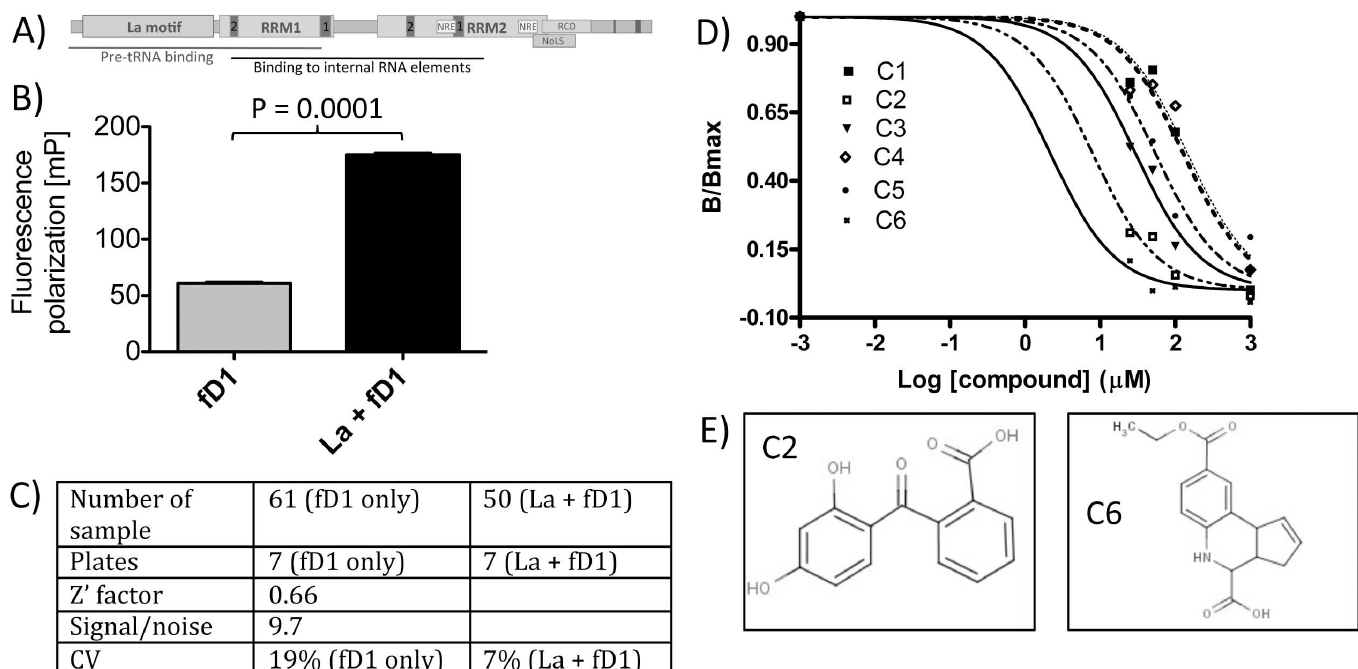
Fig 1. The La:RNA fluorescence polarization assay (La-FP assay). A) Domainstructure of La wildtype(La-WT). RRM = RNA recognition motif with RNP1 and RNP2 consensus sequences.Lines indicate which domainsare requiredfor bindingto different RNA substrates. NRE = nuclear retention element; NoLS = nucleolar localization signal;RCD = RNA chaperone domain; C-terminal dark bar = nuclear localization signal. B) Fluorescence polarization (FP) of the fluorescence-labeledcyclin D1-RNAoligonucleotide (fD1-RNA) in the absenceand presenceof recombinant La protein. C) Quality statistic for the La-FP assay. Z’ factor, signal to noise ratio and the coefficient of variation(CV) were determined by recording fluorescence polarizationsignalsof fD1-RNA alone and in the presenceof recombinant La. Measurements from seven microtiter plates performed at different days were combinedto ensure proper statistics. D) La-FP on fD1-RNA in the presenceof compoundC1 to C6 at increasing concentrations. La protein (1.35 μ M) was incubatedwith each compoundat 25, 50, 100, 1000 μ M for 30 min, followedby additional15 min incubation with 0.8 μ M fD1-RNA to detect the residualactivity of the labeledfD1-RNA binding.Mean values of B/B max (B max = maximal bindingin absenceof compound)were plotted against the compoundconcentrations ( μ M). B max = Δ mP max = mPs − mP free is the maximum specific binding,which definescompletesaturation of La protein with fD1-RNA in the absenceof a compound. B was determinedas the difference betweenfluorescence polarizationof fD1-RNA plus La plus compoundand fluorescence polarization of fD1-RNA plus compound.IC 50 values were determined using mean values of B/ B max in a non-linearregressionanalysisby GraphPad Prism version4.00 for Windows (GraphPad Software, Inc, San Diego, CA). E) The structures of the best two hits, C2 and C6, are